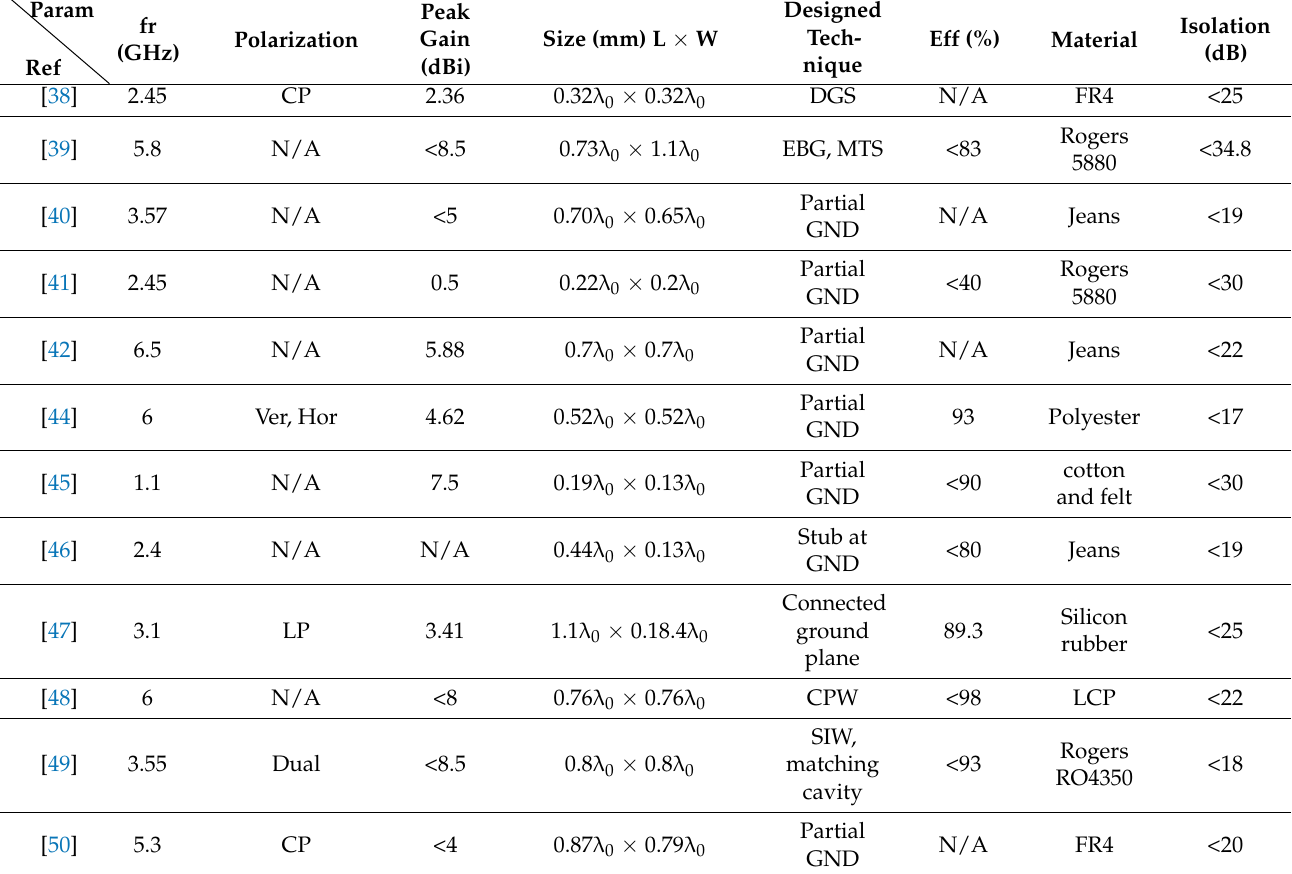
Table 1. Comparison of flexible/wearable MIMO antenna in the